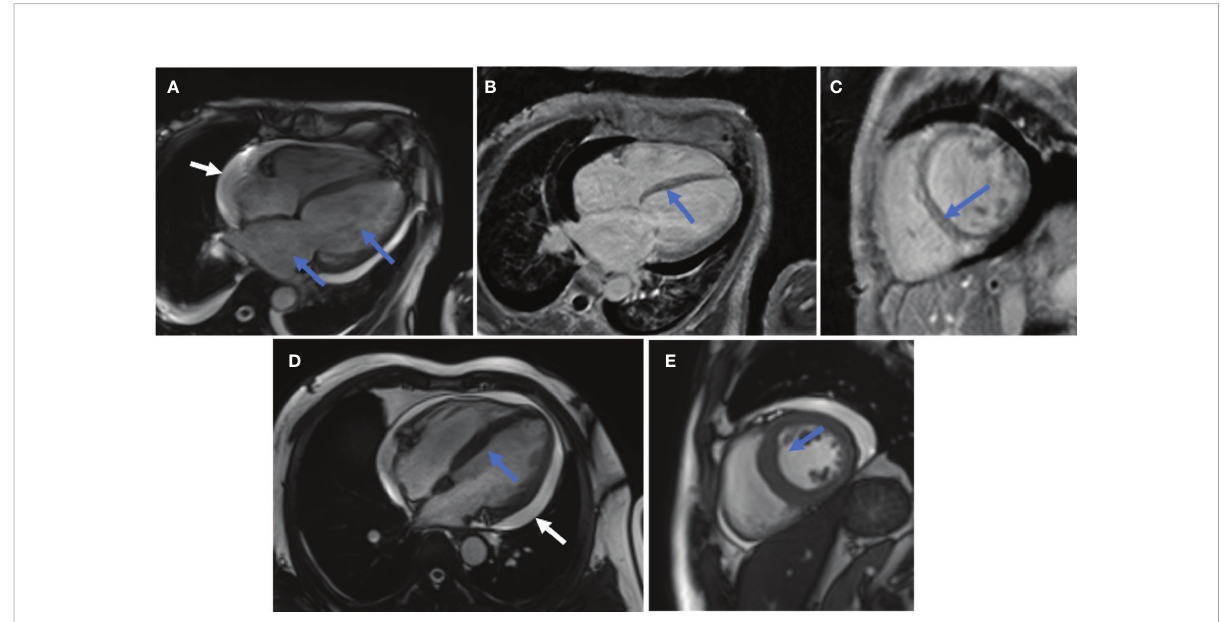
FIGURE 1 Representative CMR images. (A – C) , patient 2. (A) , Enlarged left atrium and left ventricle (blue arrow); pericardial effusion (white arrow). (B, C) , Linear LGE in the basal-mid segment of ventricular septum ( B in long-axis view, C in short-axis view). (D, E) , patient 4. (D) , Thickened ventricular septum (blue arrow) and pericardial effusion (white arrow) in long-axis view. (E) , Thickened ventricular septum (blue arrow) in short-axis